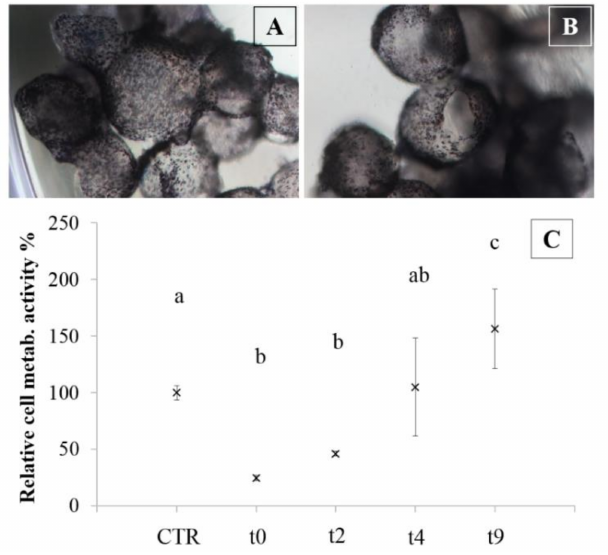
Figure 7. Formazan staining for viable cells on silk/alginate microcarriers, before cryopreservation ( A ) and seven days after thawing ( B ). Magnification of 5 × . Relative cell metabolic activity % ( C ), expressed as mean values ± standard deviation of encapsulated chondrocytes before cryopreservation (control) and after thawing process (t0-2-4-9 days). Different letters indicate significant differences ( p < 0.05). Overall we considered three bead batches, produced from three nasal chondrocyte lines and, for each considered time, three beads were analyzed (experimental sample size n =